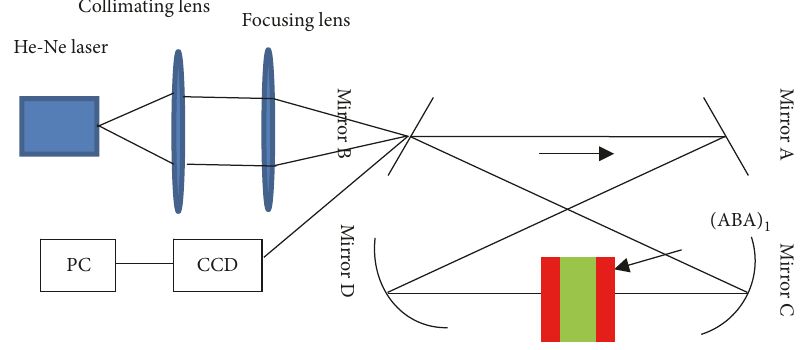
Figure 4: Light path schematic diagram of ring resonator sensor.